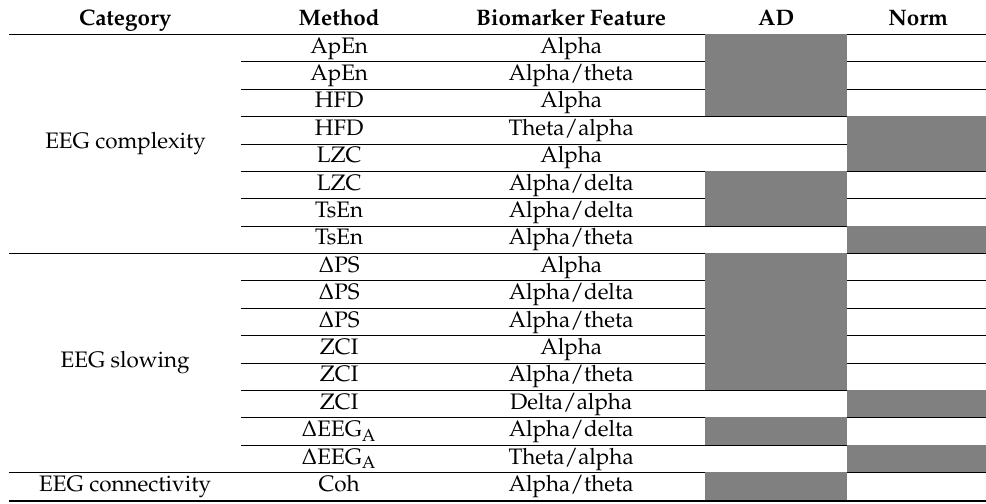
Table 8. Changes in EEG signal due to AD for all the 17 robust EEG biomarker panels. Category Method Biomarker Feature AD Norm